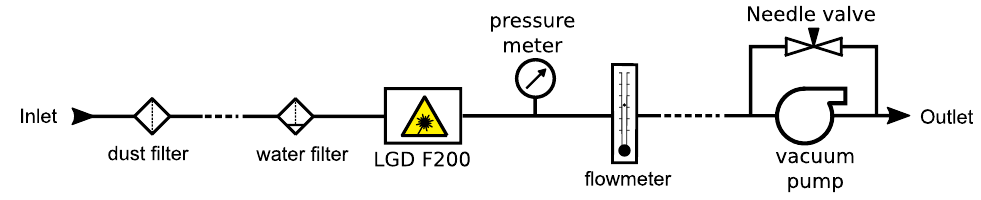
Figure 2. A generic measurement setup of the Axetris LGD F200-A NH 3 . The dashed lines indicate where the PTFE tube length was extended according to practical needs.